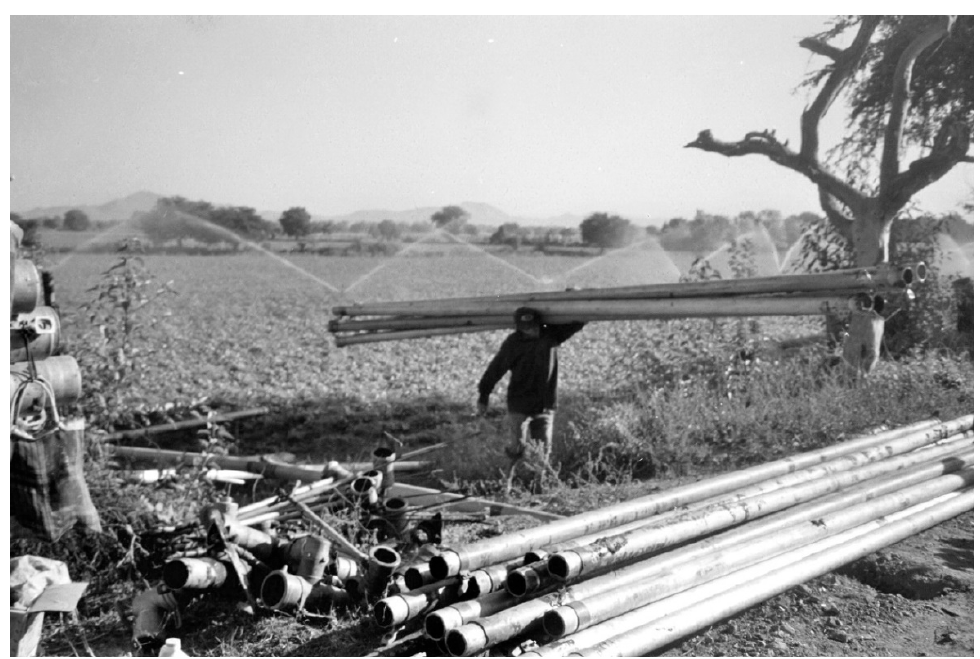
Figure 3. Pump operator carrying pipes.